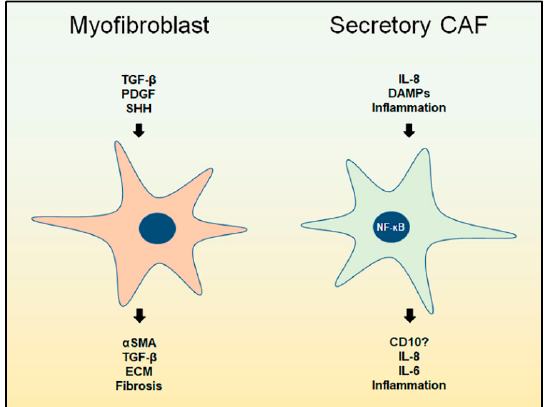
Figure 1. Cancer-associated fibroblasts (CAFs) functional subsets in pancreatic ductal adenocarcinoma (PDAC). Myofibroblasts promote fibrogenic conditions, including increased extracellular matrix (ECM) production, and develop in response to several stimuli, including transforming growth factor beta (TGF- β ), platelet-derived growth factor (PDGF) and sonic hedgehog (SHH). Secretory CAFs contribute to inflammation and develop in response to inflammatory mediators, including C-X-C motif ligand (CXCL)8 and damage-associated molecular patterns (DAMPs).